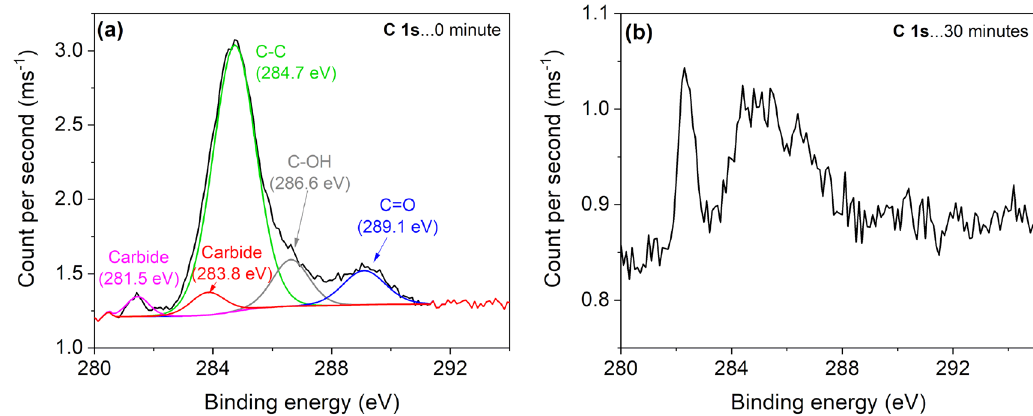
Figure 6. The measured and fitted XPS spectra attributed to C before etching ( a ) and the measured XPS spectrum after 30 min of Ar n+ etching ( b ).